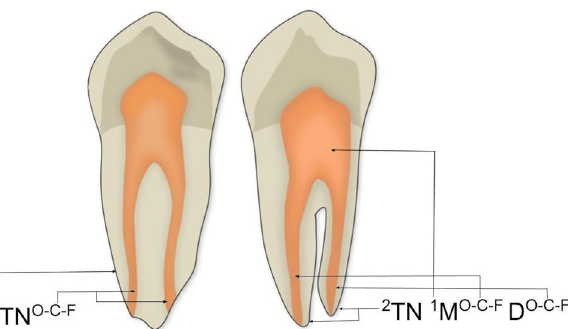
Figure 2. Representative illustrations of the root canal system morphology coded according to Ahmed’s criteria. The superscript on the left of TN corresponds to the number of roots. The superscript on the right of TN, in a single-rooted tooth, corresponds to the root canal configuration type, and in a double-rooted tooth, corresponds to the root canal configuration type on the right of each root, being M: mesial and D: distal. Whether the root has a common configuration coronal to canal bifurcation, then the canal configuration common to both root is written before the identification of the roots. The same code applies to multi-rooted teeth. O–C–F corresponds to the root canal configuration type starting from the orifice, passing through the canal to the foramen. TN tooth number.